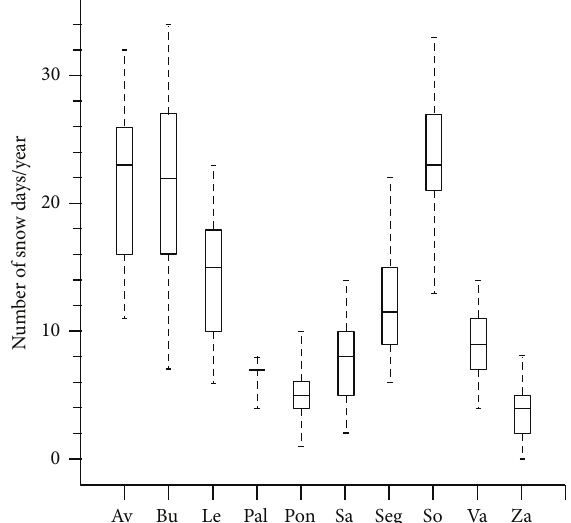
Figure 2: Box and whisker plot for number of snow days/year for each station (´Avila, Burgos, Le´on, Palencia, Ponferrada, Salamanca, Segovia, Soria, Valladolid, and Zamora). The lower end of the box indicates the 25th percentile, the central line indicates the median, and the line above the box indicates the 75th percentile. The error lines above and below the box indicate the 95th and 5th percentiles,